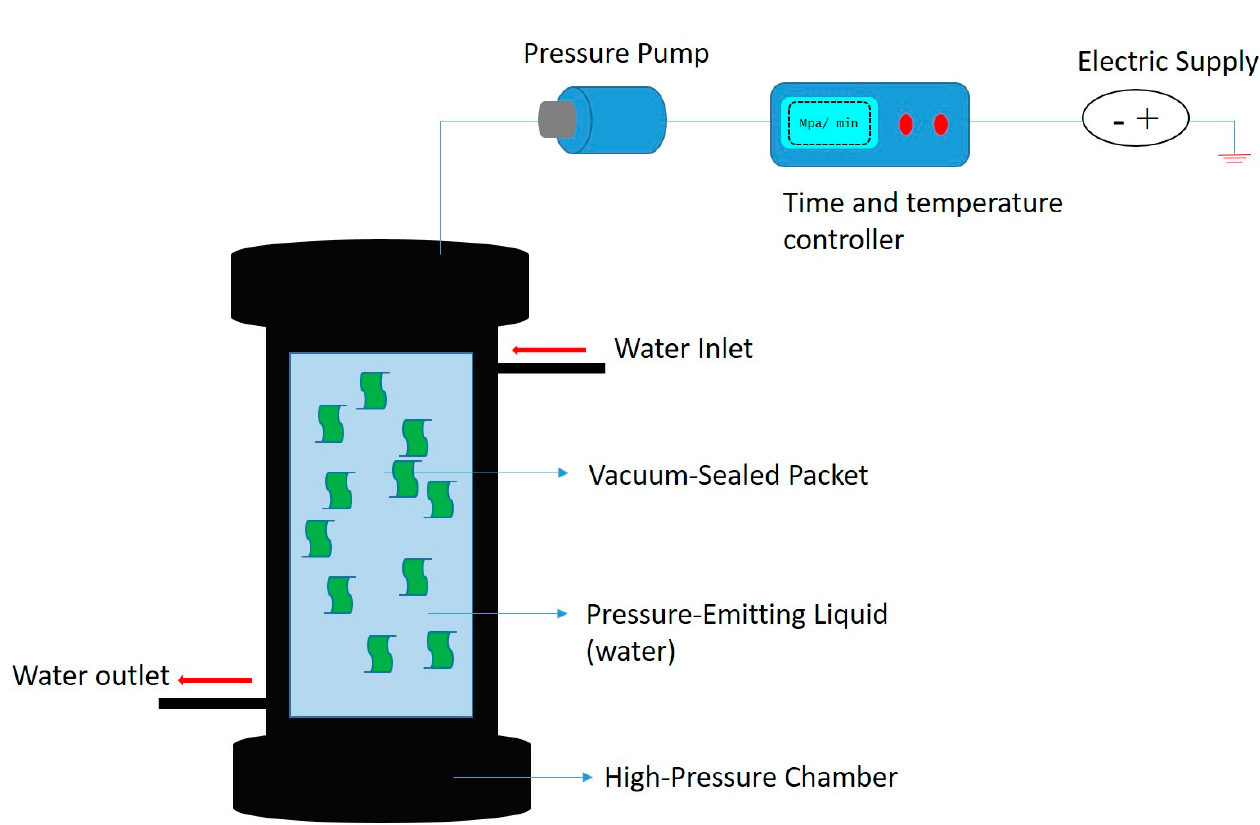
Figure 6. Schematic representation of high-pressure processing.